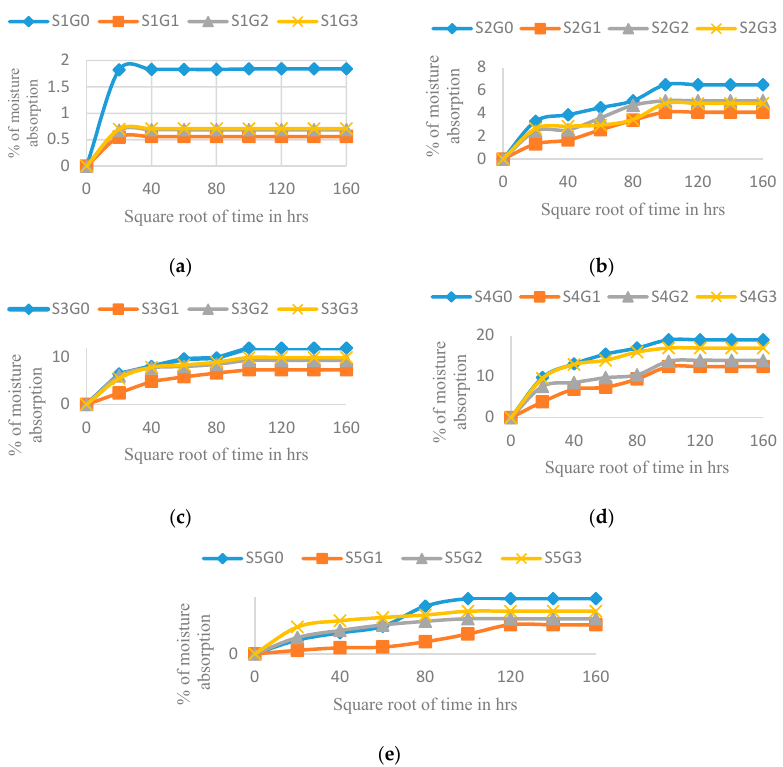
Figure 10. The effect of GNP on the water sorption behaviour of hybrid laminates. ( a ) S1; ( b ) S2; ( c ) S3; ( d ) S4; and ( e ) S5. Table 9. The moisture diffusion analysis.